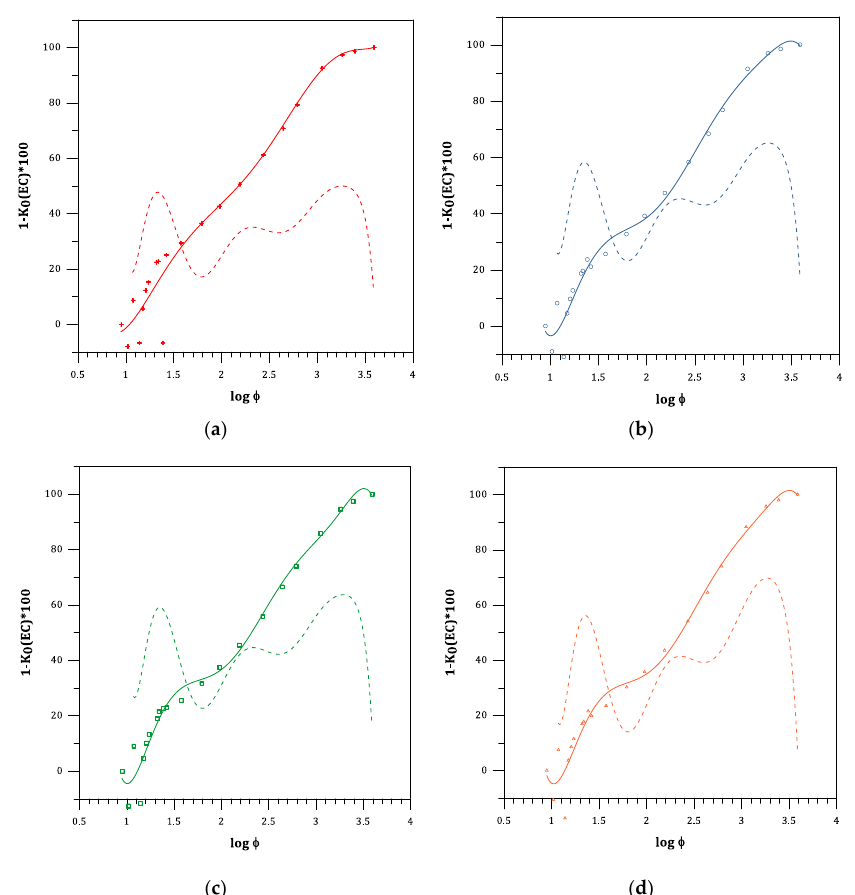
Figure 5. ISEC cumulative (―) and differential (‒ ‒) pore size distribution curves for the obtained copolymers: ( a ) GE; ( b ) GE-OH; ( c ) GE-COOH; ( d ) GE-S-COOH.